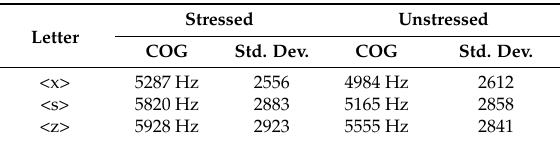
Table 5. Mean COG values in Hz and standard deviations by letter and